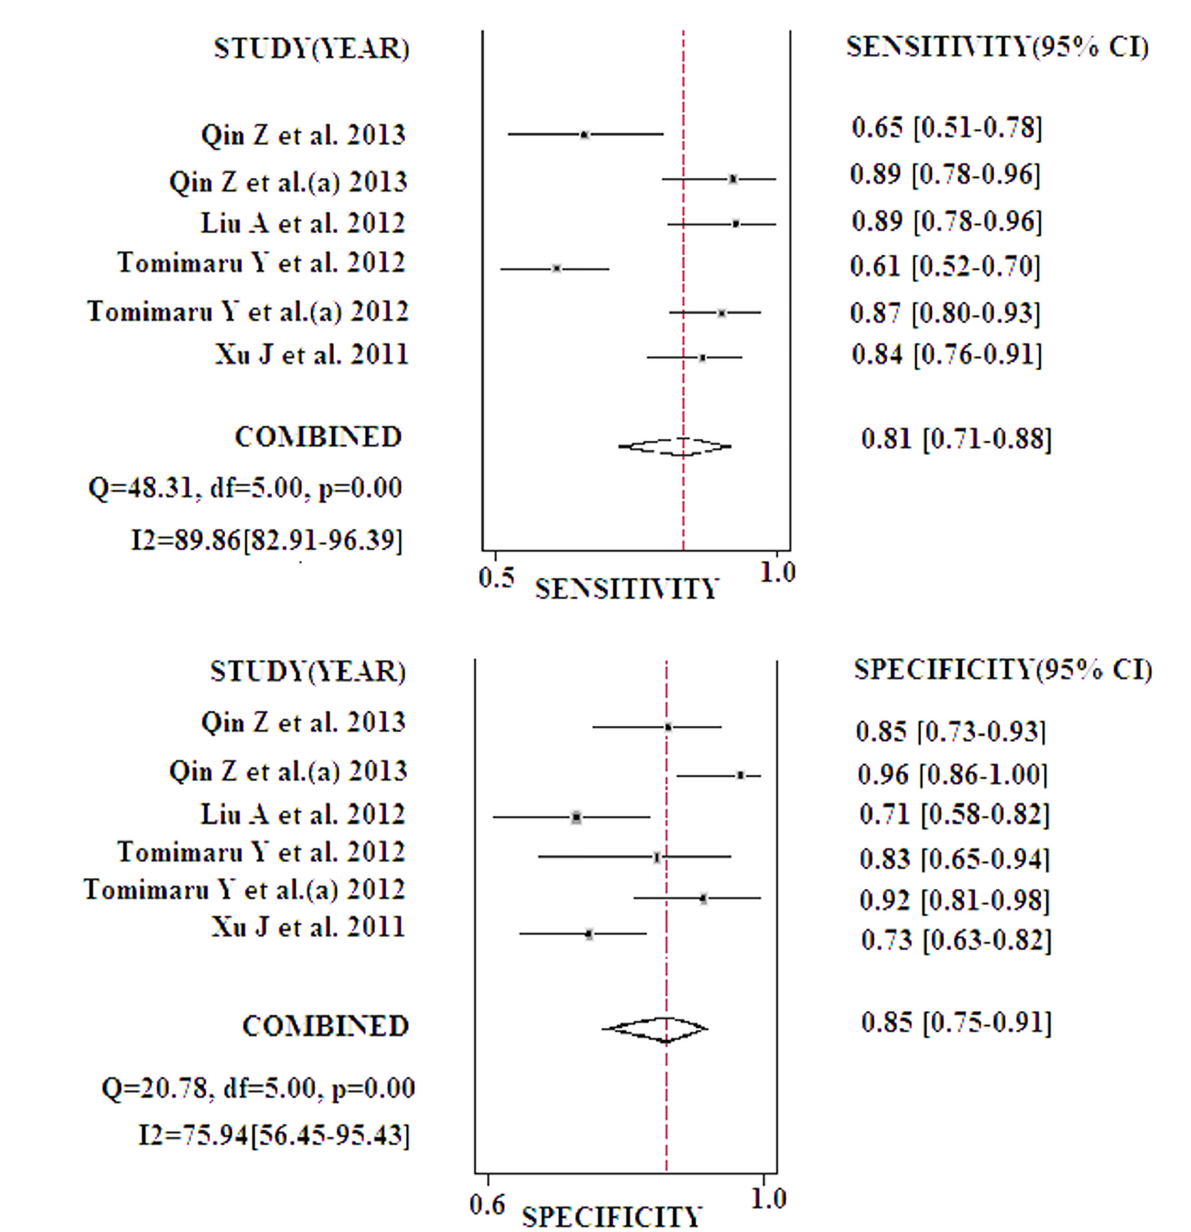
Fig 2. Forest plot of sensitivities and specificities from the test accuracy of circulating miR-21 in the diagnosis of HCC.